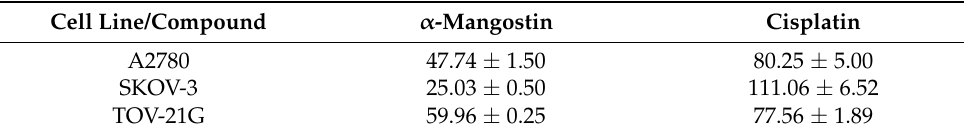
Table 1. IC50 value [ µ M] for α -mangostin and cisplatin against A2780, SKOV-3, and TOV-21G cells for 24 h incubation.